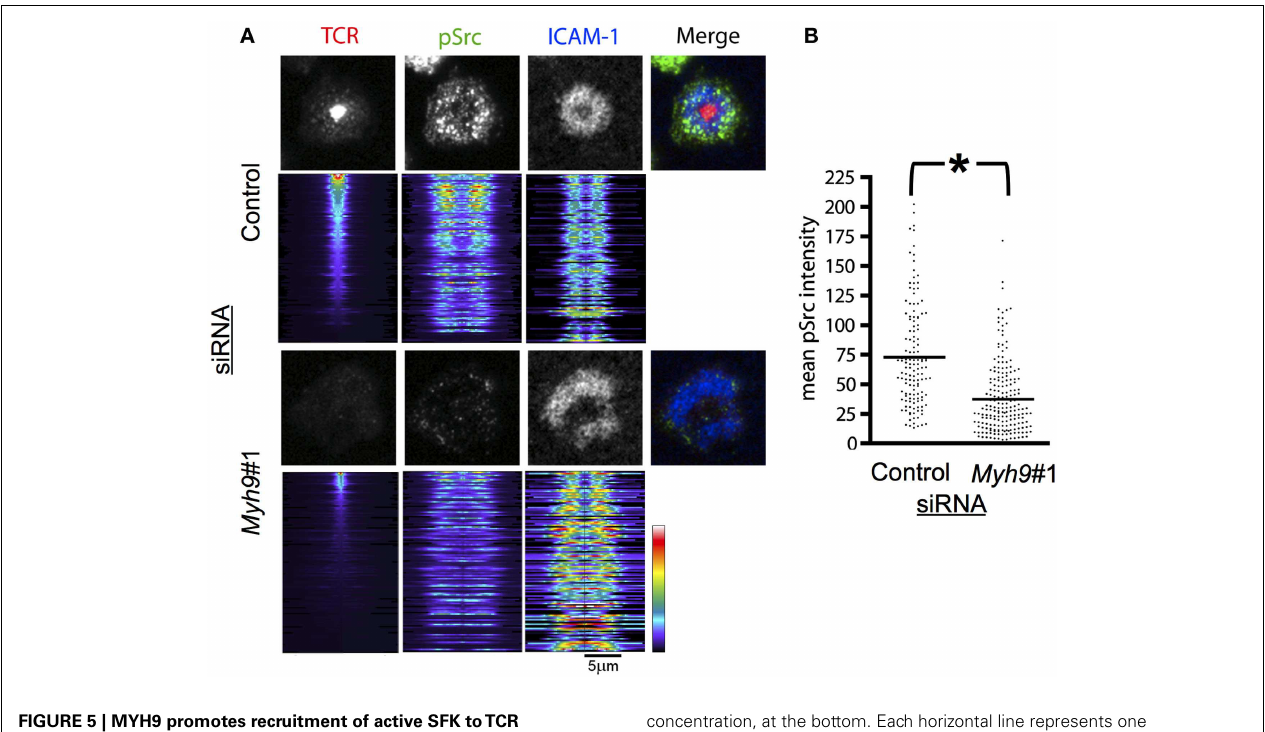
FIGURE 5 | MYH9 promotes recruitment of active SFK toTCR microclusters. (A) Indirect immunofluorescence for pSrc (green), ICAM-1 (blue), and H57 Fab (TCR, red) in ANDT cells treated with control or Myh9 #1 siRNA and incubated with reconstituted bilayers for 15min. Below each representative cell fluorescent image is the stack of radial line scans originating at theTCR centroid and sorted by highest concentrationTCR cSMAC, at the top, to the lowest